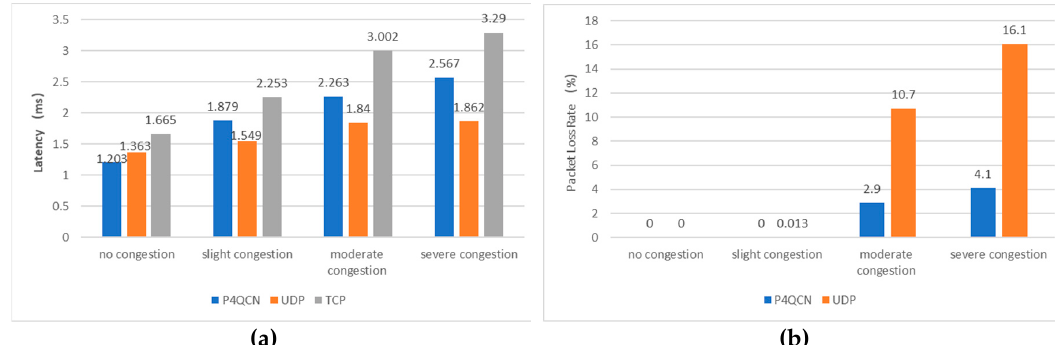
Figure 13. ( a ) Latency comparison of P4QCN, UDP and TCP; ( b ) Packet loss comparison of P4QCN and UDP.